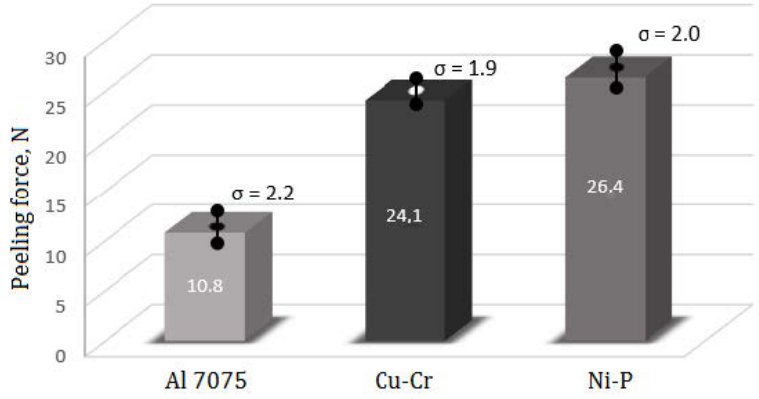
Figure 2. Results of the scratch test.